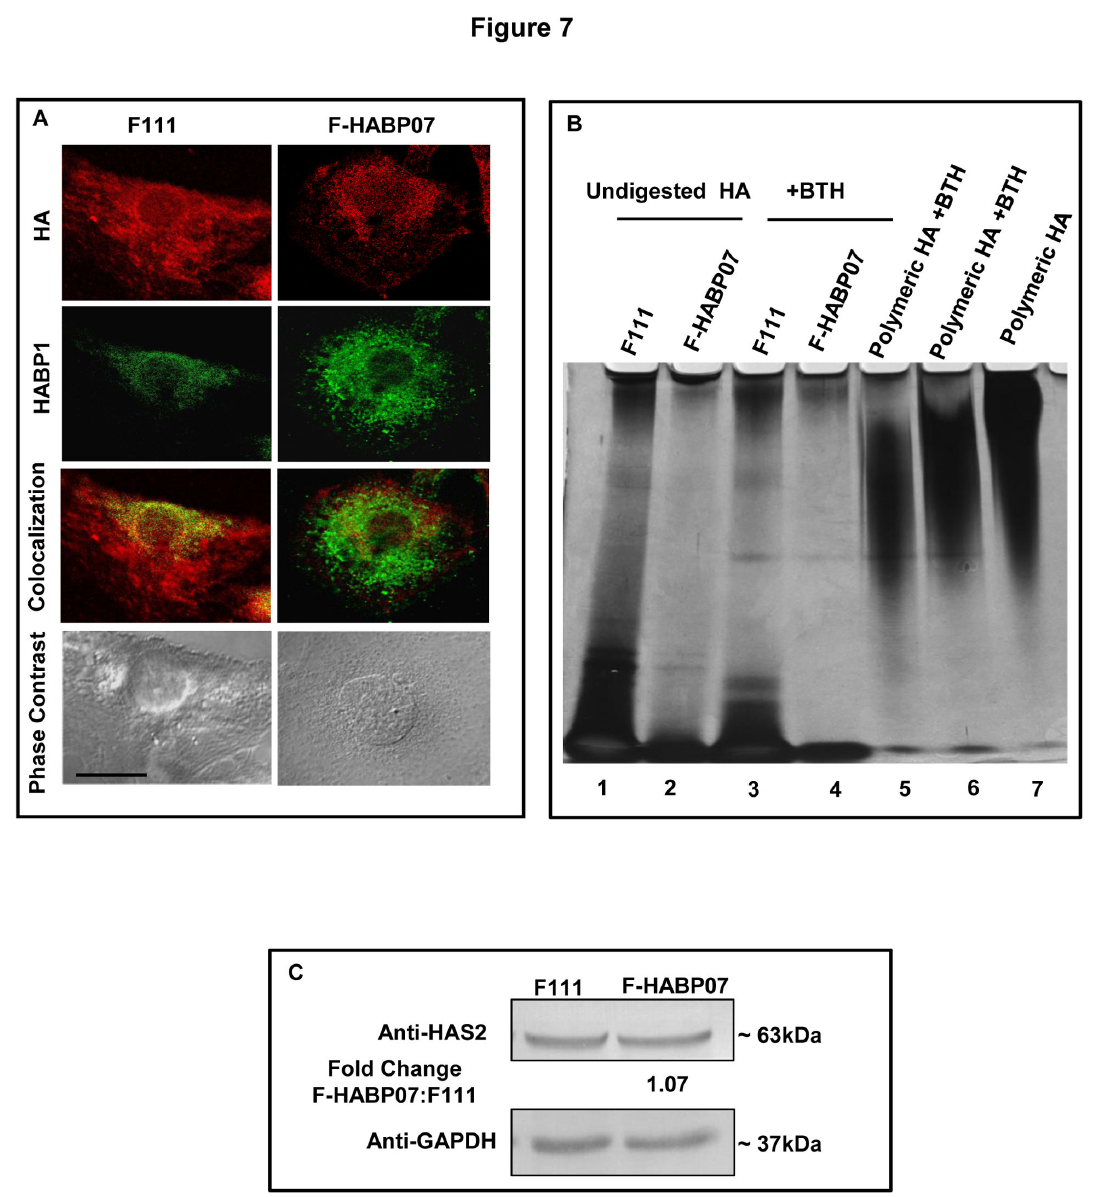
Figure 7. Depolymerized and depleted HA in excess ROS generating HABP1 overexpressing fibroblasts. [A] Colocalization study of HA with HABP1 -- Cytotochemical staining for hyaluronan was performed in normal F111 and F-HABP07 using biotinylated hyaluronan binding protein and probed with streptavidin conjugated with Alexa Fluor 568. The depletion of HA polymer resulting from oxidant release by HABP1 overexpression in F-HABP07 cells (column 2) with respect to parental control cells (column 1) can be explained since HA polymer is known to be most susceptible to ROS-mediated degradation to HA oligosaccharide. Row 4 represents the morphology of two cell lines by phase contrast microscopy. Scale bar represents 10μm for all. [B] Detection of depleted and depolymerized HA in F-HABP07-- HA was purified from both F111 and F-HABP07 cells and then subjected to digestion with 50µg/ml of BTH. Equal volumes of both the undigested (lane 1 and 2) and BTH-digested products from the two cell lines (lane 3 and 4) were electrophoresed onto a 5–20% gradient polyacrylamide gel. Commercially available polymeric HA (lane 7) and two different concentrations of the same polymeric HA treated with BTH (lane 5 and 6) were taken as controls. The gel was stained with 1% Alcian blue in 3% acetic acid and then subsequently with silver nitrate. A significantly reduced level of polymeric HA in F-HABP07 cells is clearly evident as compared with the F111 cells and the high molecular weight HA further disappears upon subsequent treatment with BTH. [C] Detection of HAS2 level -- Western blotting performed on cell lysates of F111 and F-HABP07 grown for 60 h revealed that the expression level of HAS2 is similar in both the cell lines. doi: 10.1371/journal.pone.0078131.g007 PLOS ONE |